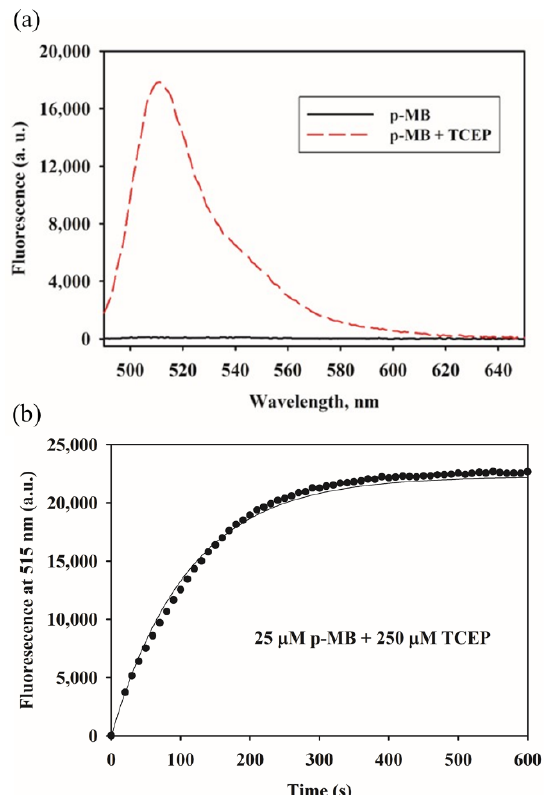
Figure 6. Reaction of p-MB with TCEP. ( a ) Emission spectra of p-MB (50 µ M) with or without TCEP (500 µ M) in PBS containing 5% DMSO ( v / v ). ( b ) Kinetics of reaction between p-MB (25 µ M) and TCEP (250 µ M). The curve was fitted to a single exponential to extract the pseudo-first order rate constant. Excitation wavelength was 470 nm. The presence of the conjugate was verified by mass spectrometry (Figure S3).